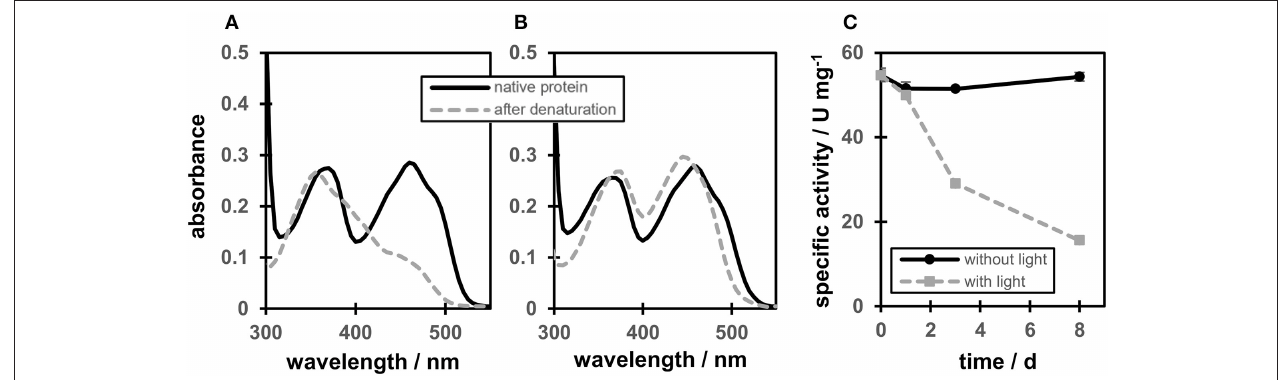
FIGURE 2 | Degradation of the flavin cofactor and stability of OYERo2a (WT). (A) OYERo2a (WT) before denaturation (black line) and free flavin after denaturation at 95 ◦ C for 20min while protein was exposed to light. (B) OYERo2a (WT) before denaturation (black line) and after denaturation at 95 ◦ C for 20min while stored in a dark water bath. (C) Specific activity of OYERo2a over a time interval of 8 days while stored at 4 ◦ C in 50mM KH 2 PO 4 /Na 2 HPO 4 buffer pH 7.1 in the dark (black line) or under exposure to light (gray